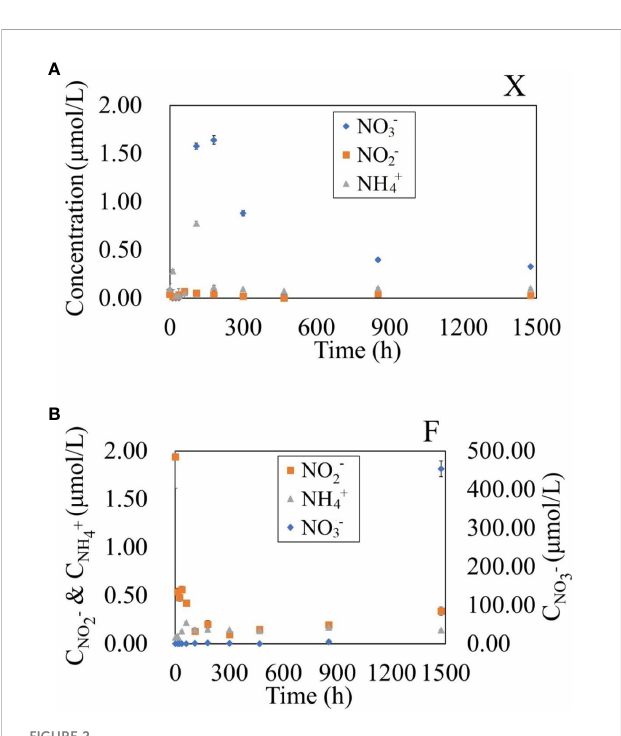
FIGURE 2 Variation of NO3-, NO2- and NH4+ concentrations in water during the degradation of fresh U. prolifera (A) and pre-decomposed U. prolifera (B) .